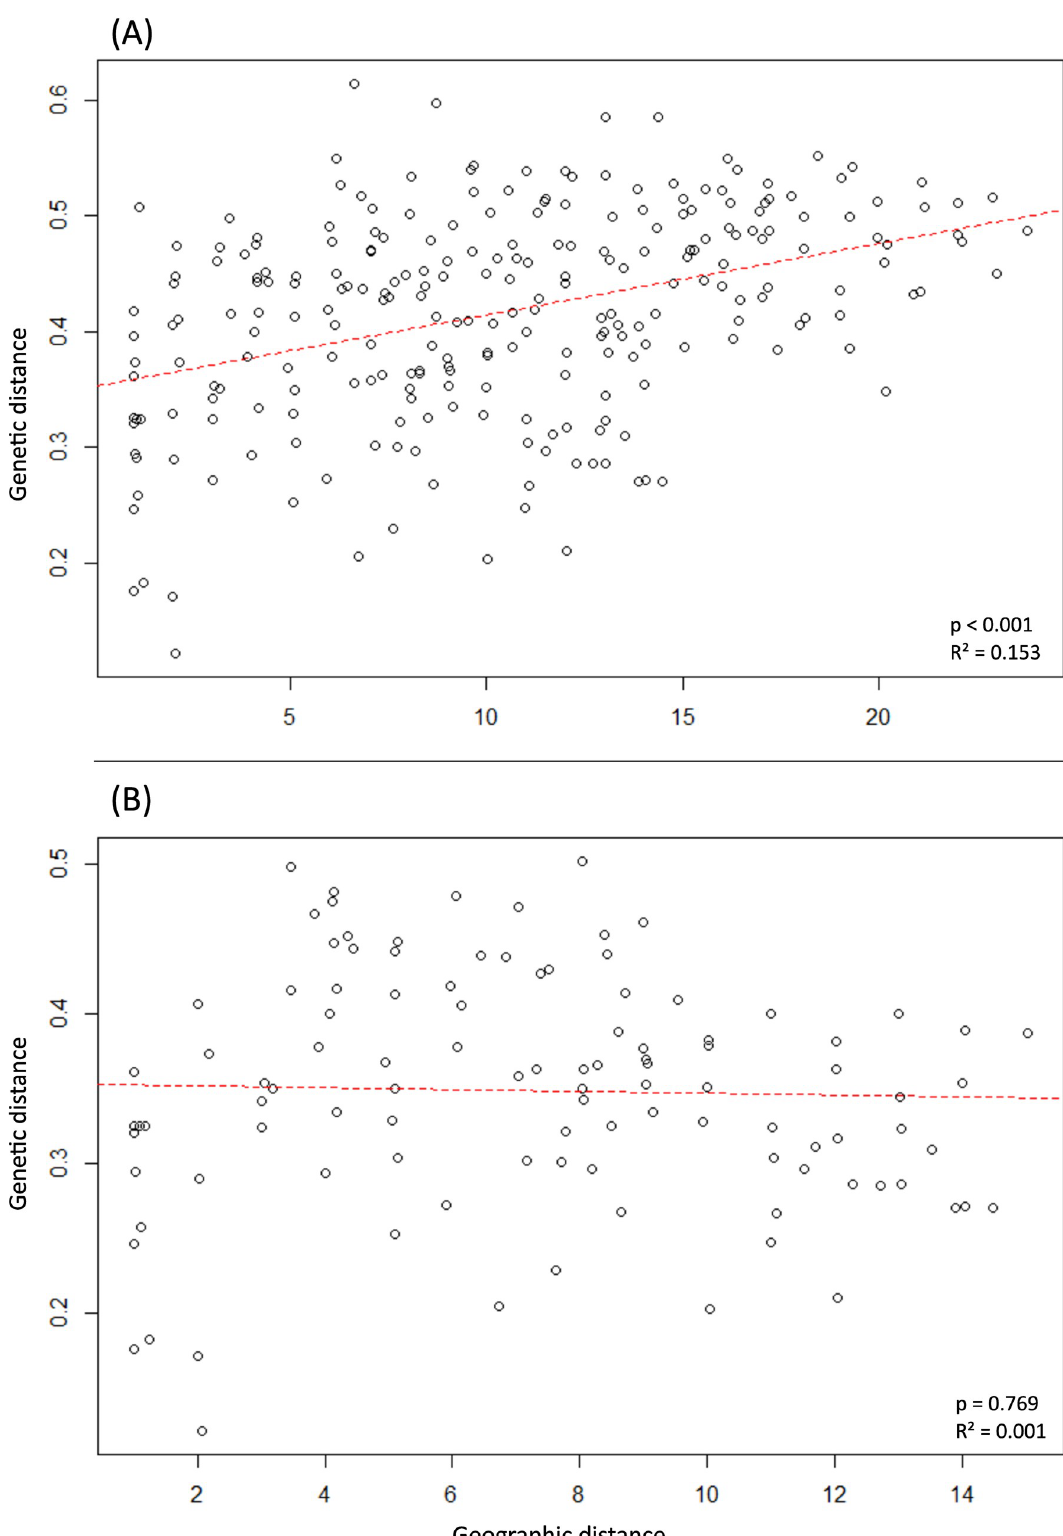
Fig 4. Isolation by distance plot. Geographic distance is displayed on the x-axis and genetic distance on the y-axis for (A) the complete dataset, and (B) the reduced dataset including only native Vietnamese populations. https://doi.org/10.1371/journal.pone.0253255.g004 PLOS ONE | https://doi.org/10.1371/journal.pone.0253255 June 23,